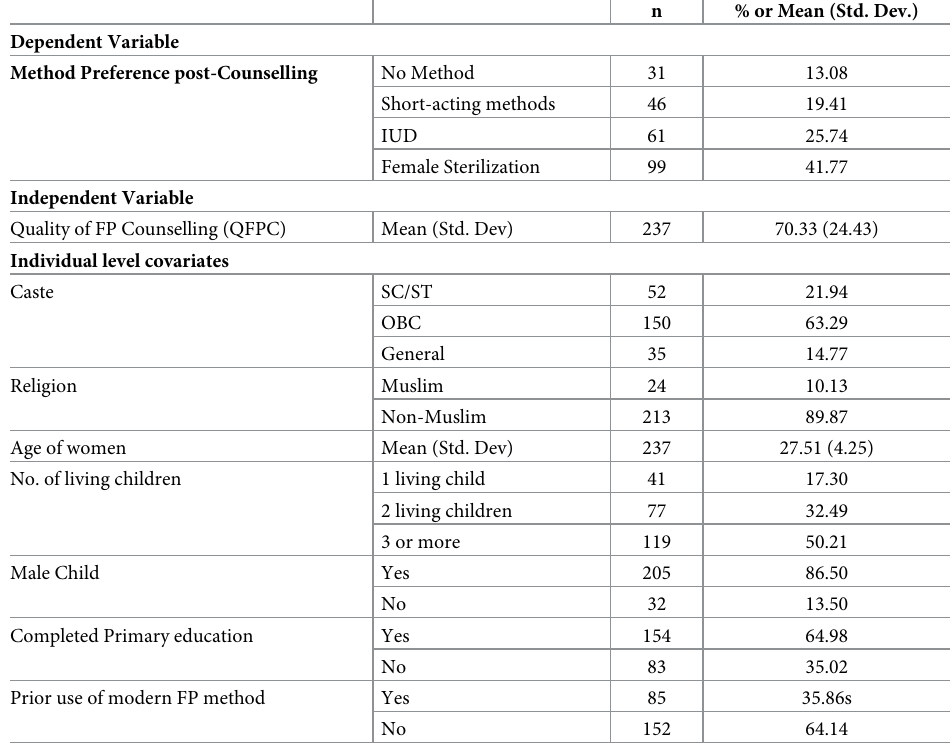
Table 1. Descriptive statistics of contraceptive method preferred post-counselling and key client level covariates (N =